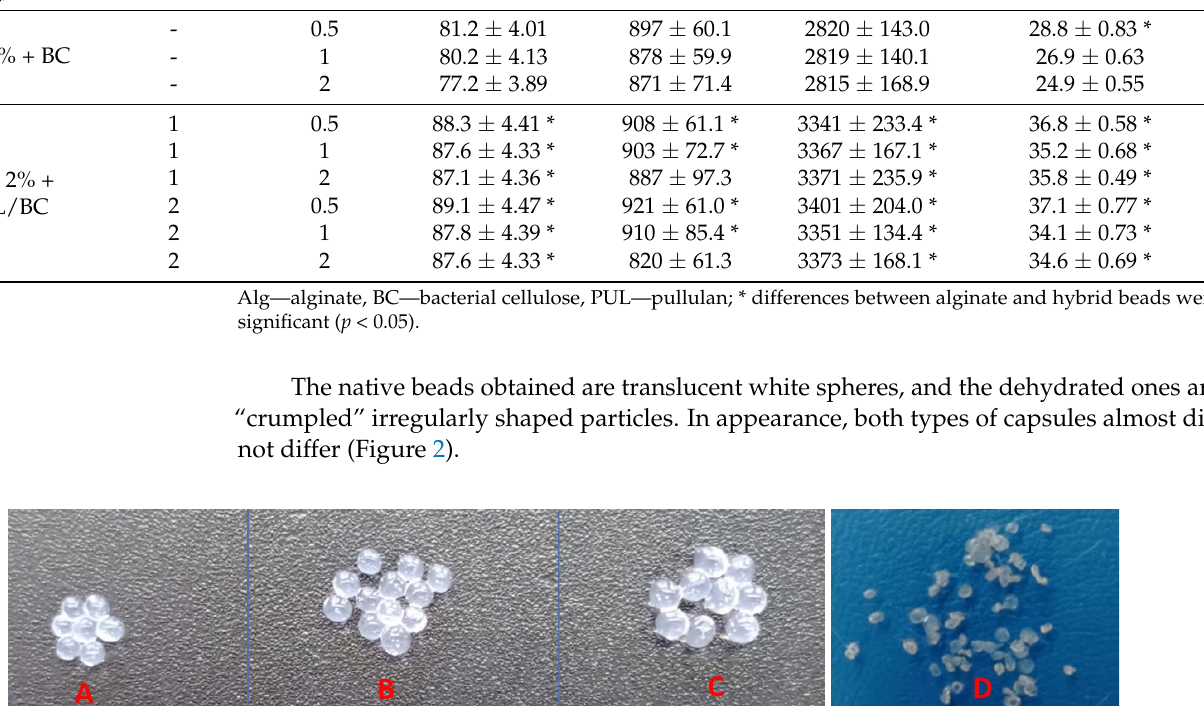
Table 1. Encapsulation efficiency (E e ), size, and mechanical strength of probiotic beads.